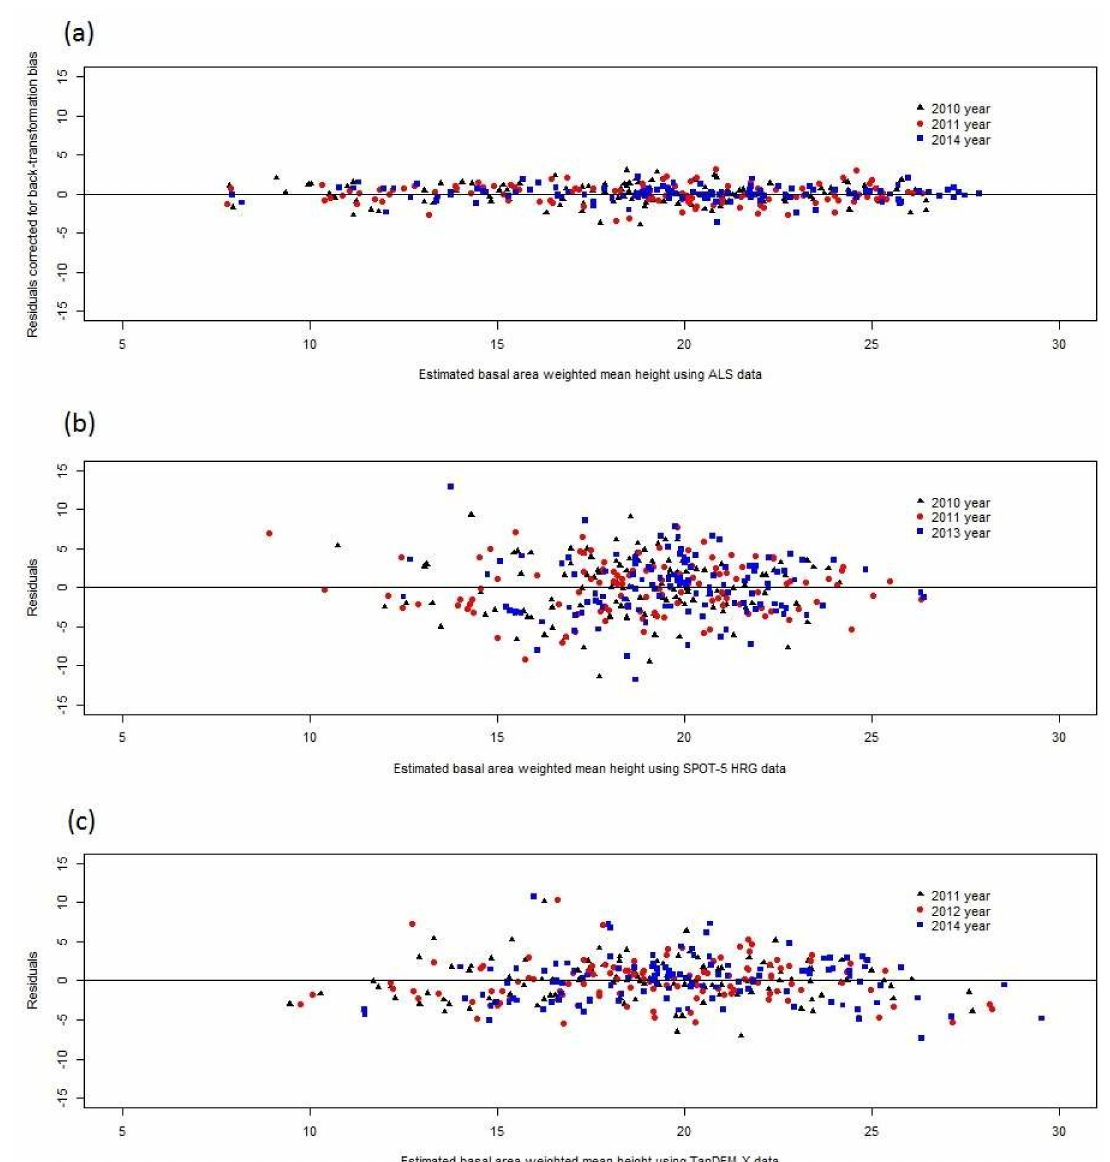
Figure A2. Estimated values versus residuals for estimated mean height using ( a ) ALS data fitted to “SEMILOG” regression model, the residuals are calculated after back-transformation and corrected for bias; ( b ) SPOT-5 HRG data fitted to “LINEAR” regression model; ( c ) TanDEM-X data fitted to “LINEAR” regression